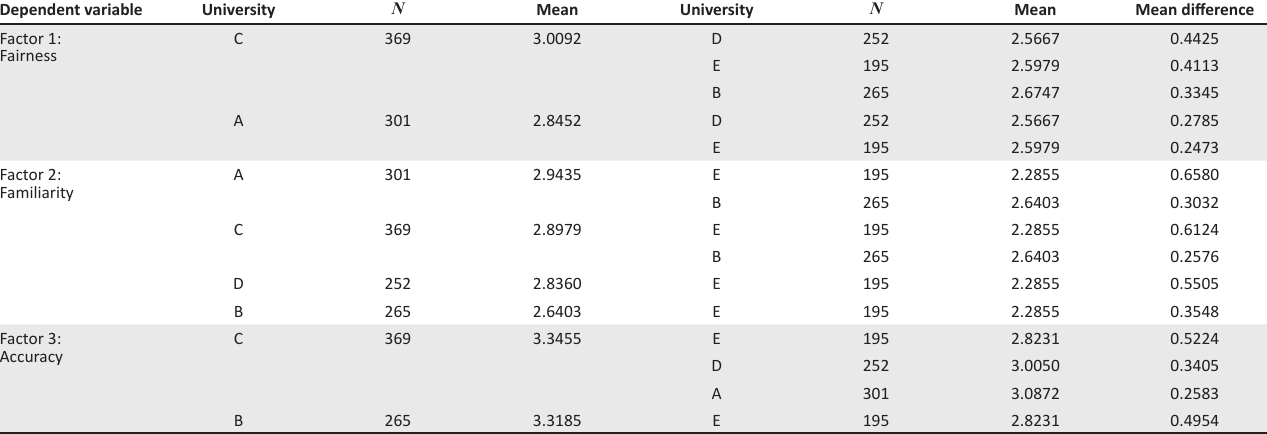
TABLE 4: Post-hoc test: Dimensions of students’ perceptions on credit management policy. Appropriateness of credit management policy. Dependent variable